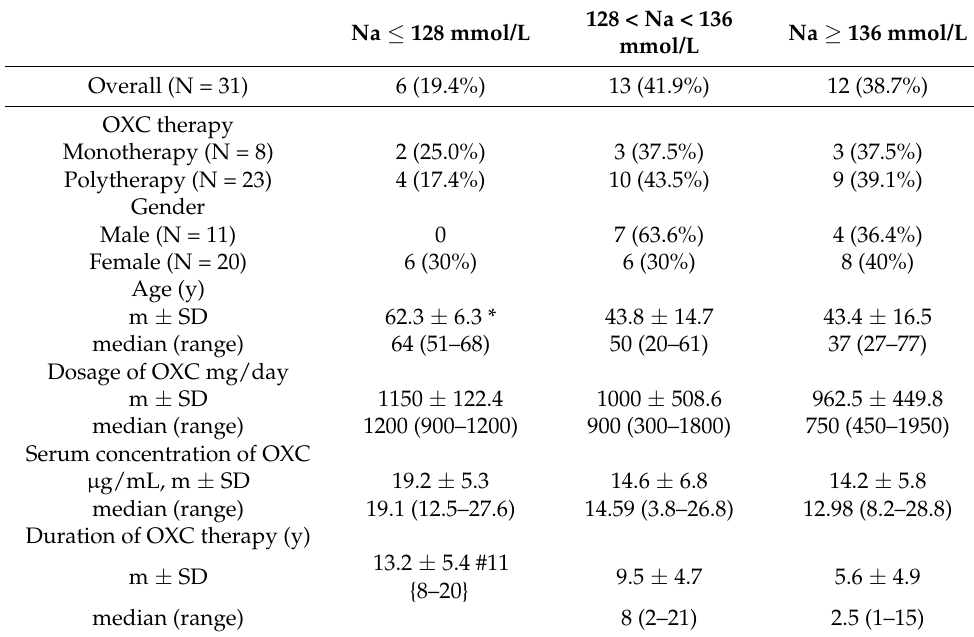
Table 4. Comparisons of demographic and clinical data between OXC- treated patients with severe, moderate hyponatremia and